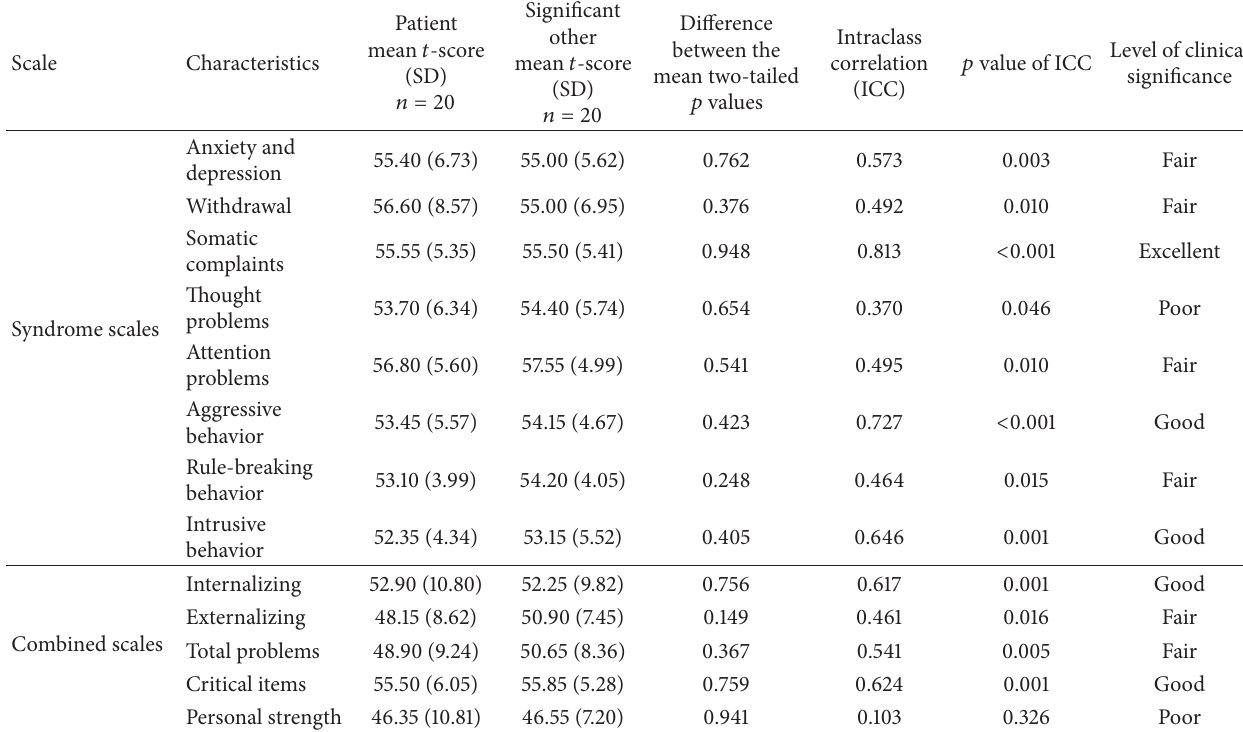
Table 4: Comparison of self-rating and